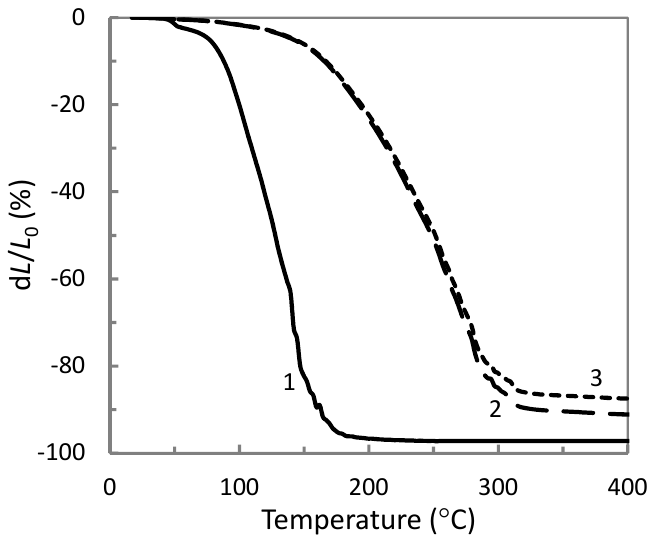
Figure 9. Thermomechanical curves of neat AP synthesized at 130 °C (1) and AP/MK composites with compositions 70/30 (2), 50/50 (3).